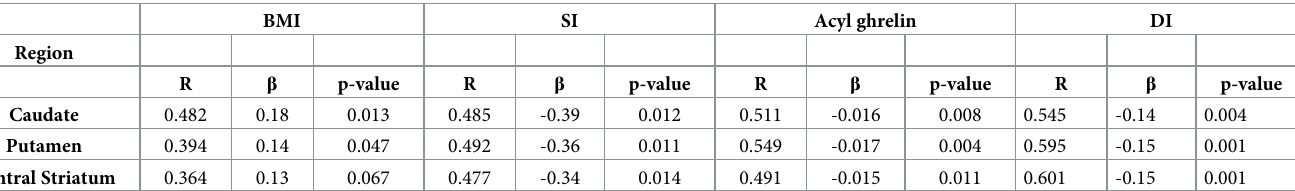
Table 2. Univariate metabolic predictors of striatal D2/3R binding